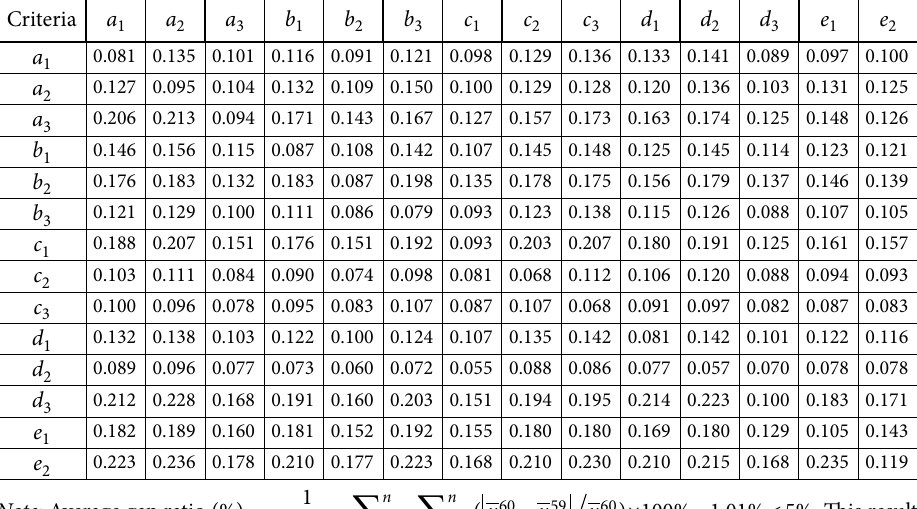
Table 4. Normalized direct influence relationship matrix T through Eq. (4) Criteria a 1 a 2 a 3 b 1 a